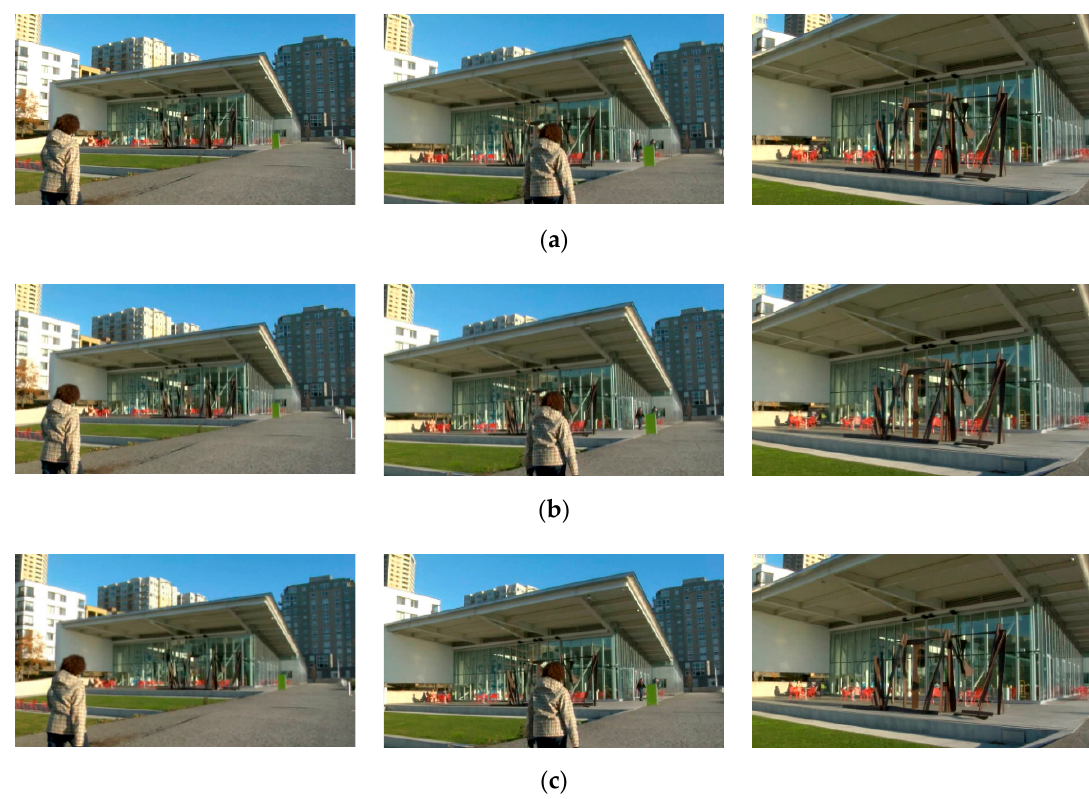
Figure 8. Video stabilization of 0004TU video sequence. ( a ) Original frames (30th, 200th, and 430th frames); ( b ) Stabilized by Deshaker; ( c ) Stabilized by proposed method.